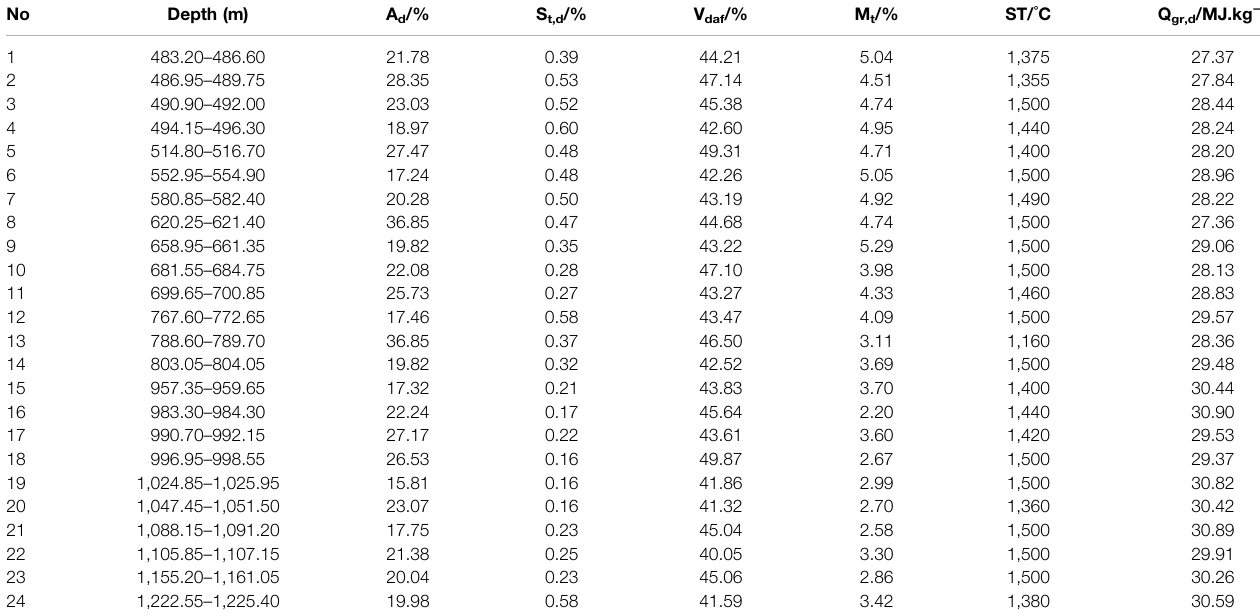
TABLE 3 | Industrial coal analysis results of a ZK1005 borehole in a coal mine. Source of data: Guo and Meng (2019).